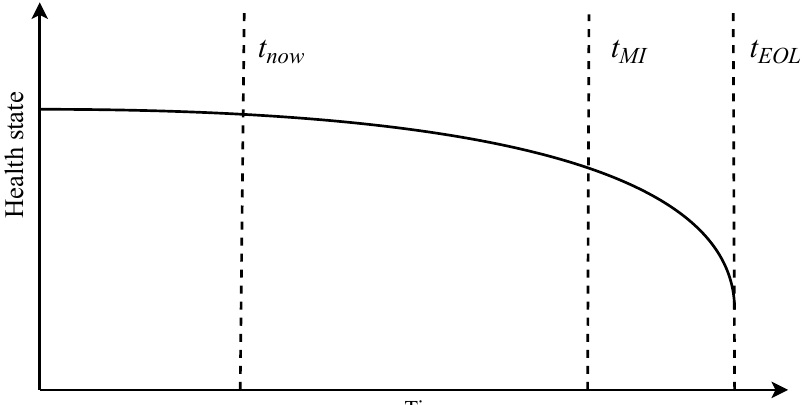
Figure 3. Maintenance scheduling at DS step (adapted from